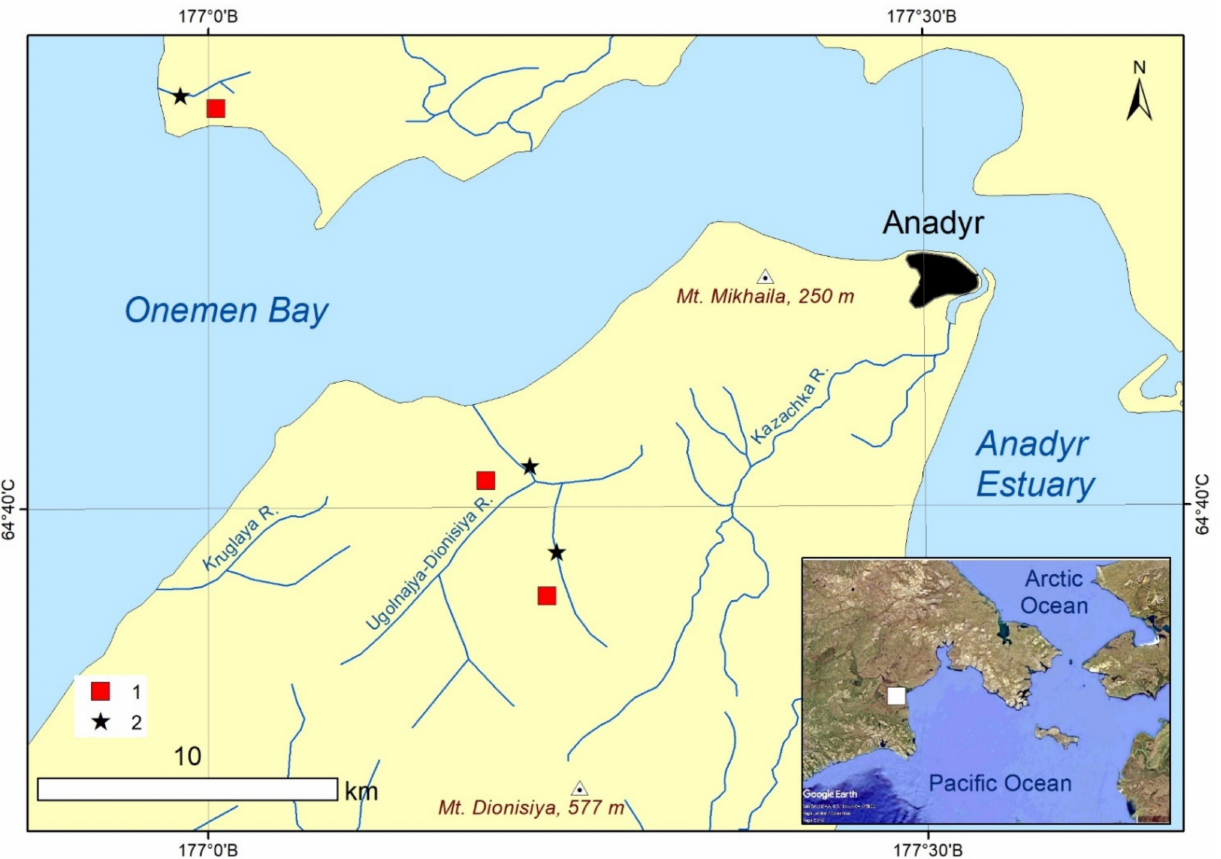
Figure 1. Layout of experimental sites and hydrological sections: (1) experimental sites, (2) hydrolog- ical